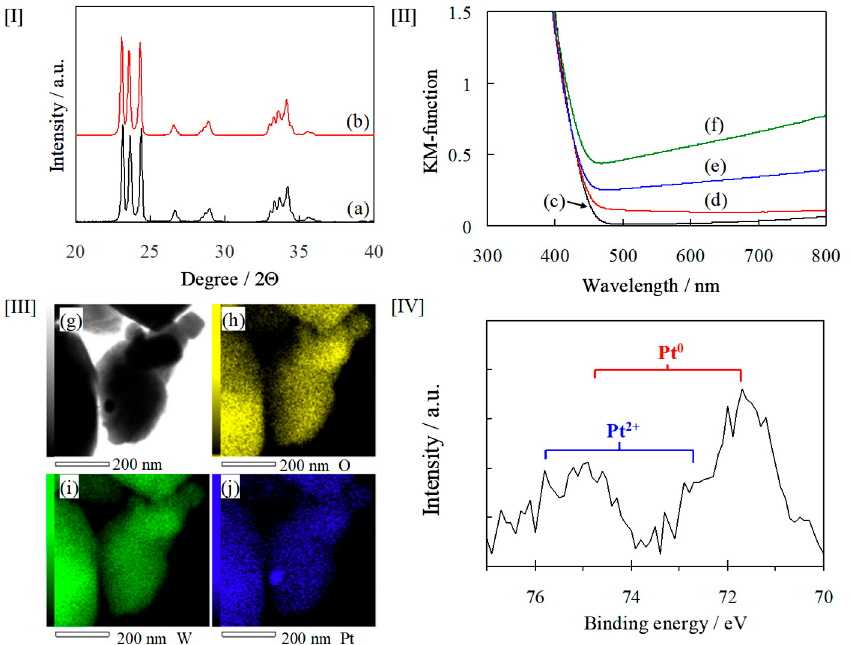
Figure 1. X-ray diffraction (XRD) patterns [ I ] of tungsten trioxide (WO 3 ) (a) and Pt(0.4)-WO 3 (platinum-tungsten trioxide) (b); ultraviolet–visible (UV–Vis) absorption spectra [ II ] of WO 3 (c), Pt(0.1)-WO 3 (d), Pt(0.2)-WO 3 (e), Pt(0.4)-WO 3 (f); scanning transmittance electron microscope (STEM) image (g) and energy-dispersed X-ray emission spectroscopy (EDS) (h–j) [ III ] of the Pt(0.4)-WO 3 : O (h), W (i) and Pt (j); and XPS [ IV ] of Pt (4f) of the Pt(0.4)-WO 3 .